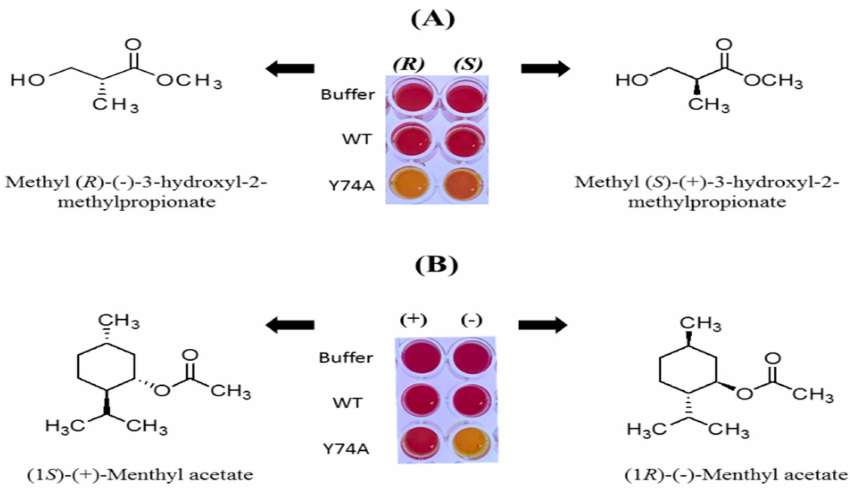
Figure 10. Enantioselectivity of wild-type Ha HSL and a Y74A mutant. ( A ) A pH shift assay toward the ( R ) or ( S ) form of methyl-3-hydroxyl-2-methylpropionate. ( B ) A pH shift assay toward the ( R ) or ( S ) form of menthyl